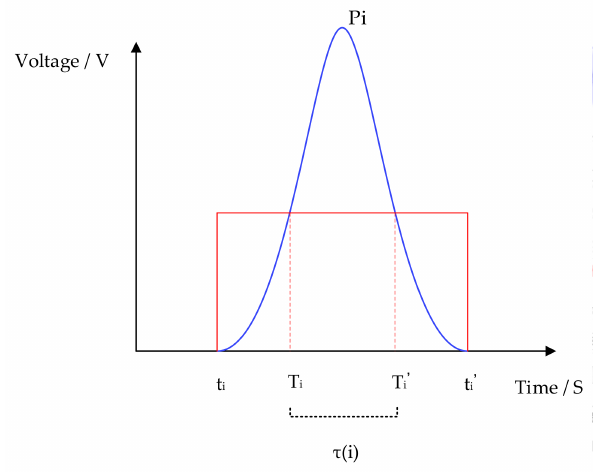
Figure 8. The parameters of p i